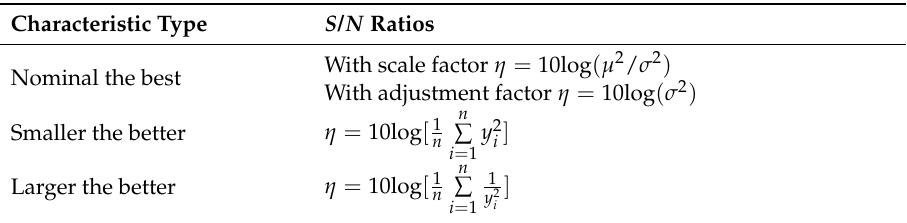
Table 2. S / N ratios for different characteristic